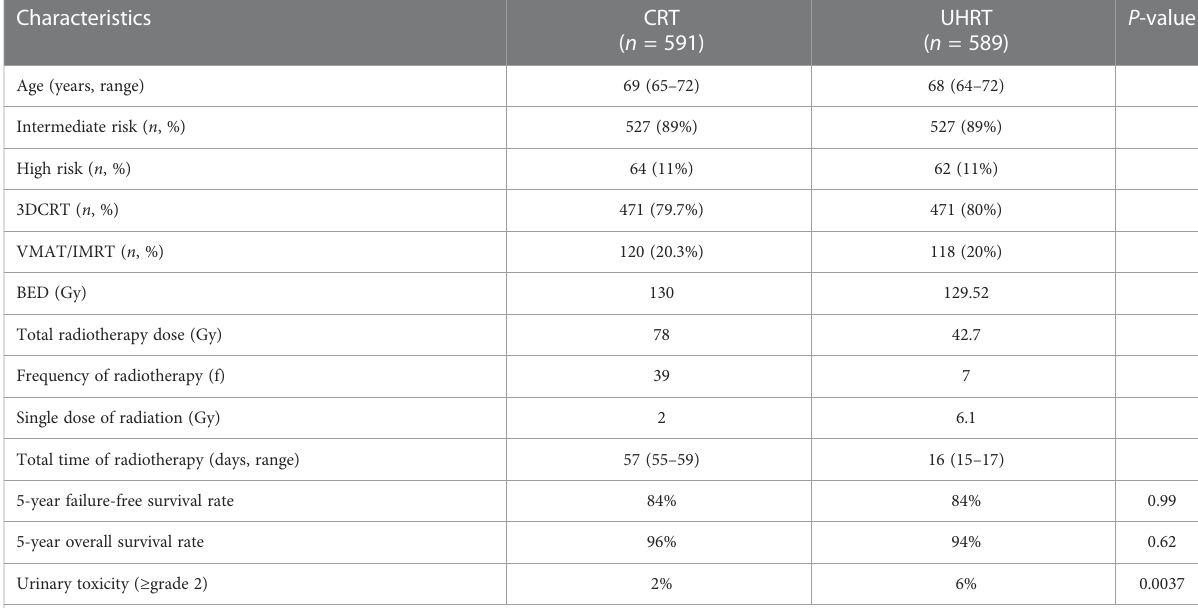
TABLE 1 Baseline demographics, clinical characteristics, and radiotherapy details were recorded between CRT and UHRT in the HYPO-RT-PC trial.